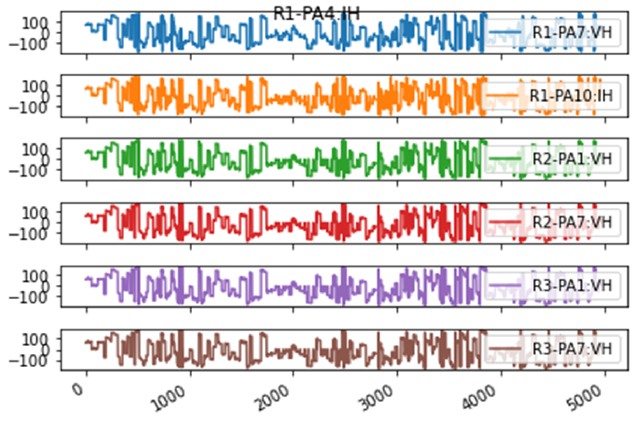
Figure 7. R1-PA4:IH correlated nodes.